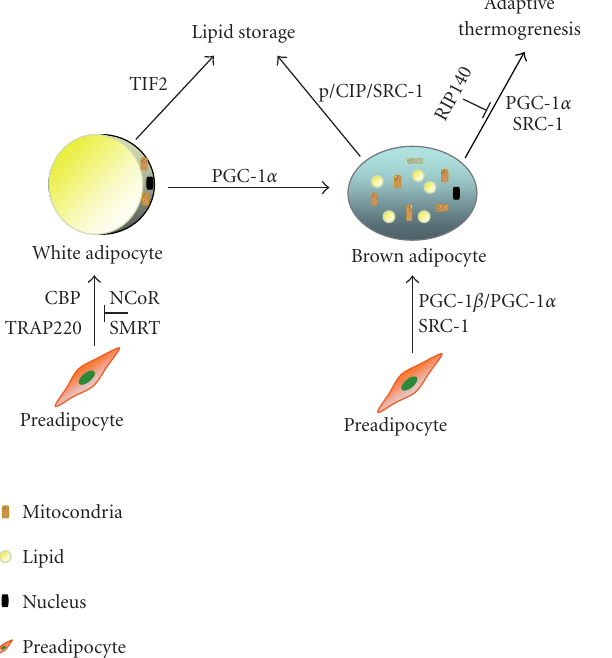
Figure 1: Putative functions of PPAR γ cofactors in white adipose- and brown adipose-modulated lipid and energy metabolism. Positive regulators are highlighted in red. Preadipocytes can be di ff erentiated into white adipocytes via transcriptional regulation of PPAR γ by coac- tivators CBP and TRAP220, or di ff erentiated into brown adipocytes via transactivation by PGC-1 β , PGC-1 α , and SRC-1. TIF2 plays roles in lipid storage from white adipocytes, while p/CIP and SRC-1 function to promote lipid storage in brown fat. PGC-1 α is not only involved in adaptive thermogenesis but it also promotes the conversion of white adipocytes into brown adipocytes. SRC-1 is the only member of p160 proteins that show clear function in energy